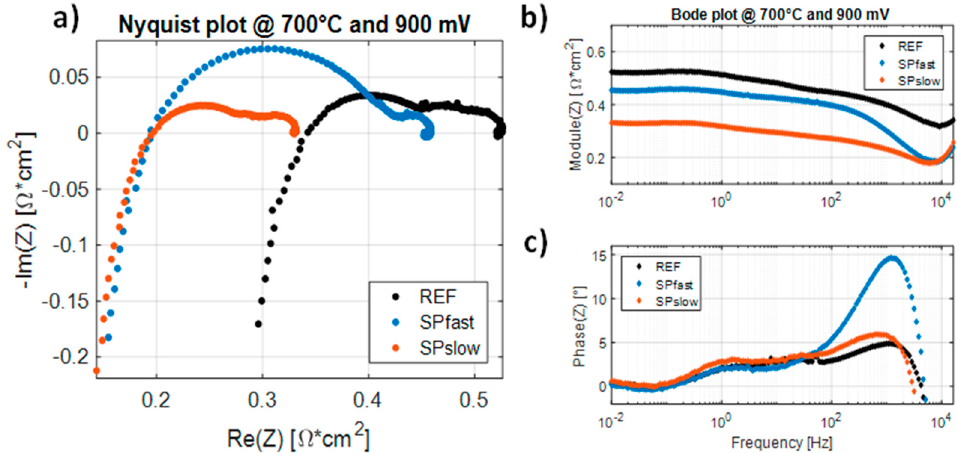
Figure 9. Nyquist ( a ) and Bode ( b , c ) plots of samples REF (black markers), SPfast (blue markers), and SPslow (red markers) measured at 700 °C and 900 mV.